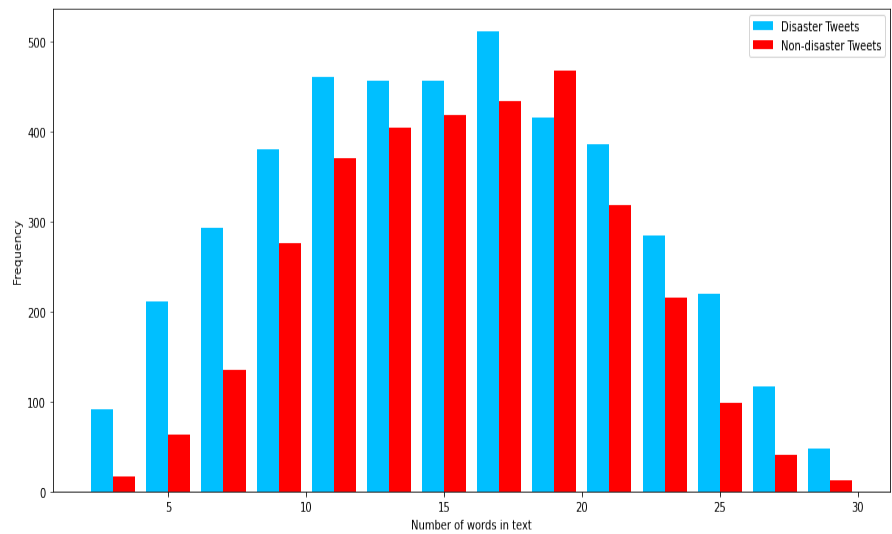
Figure 4. Word length distribution for disaster and non-disaster tweets (training data).